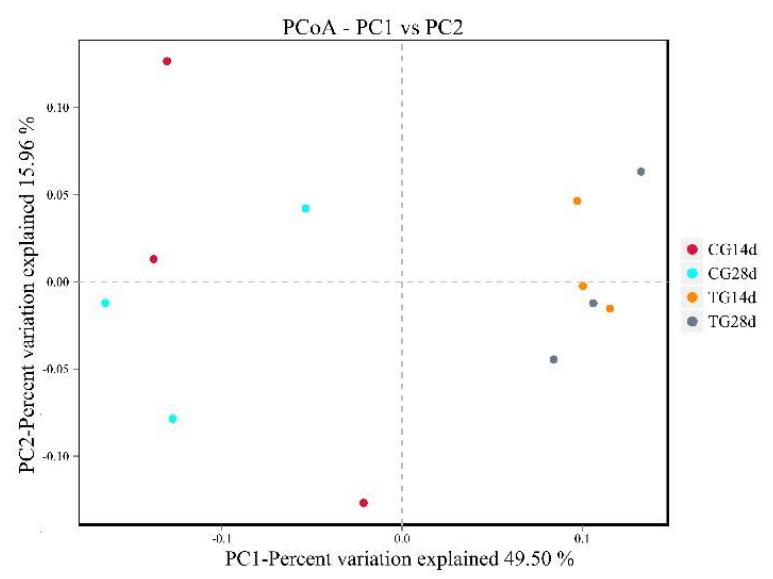
Figure 4. Principal coordinate analysis (PCoA) based on unweighted Unifrac distances. CG14d, control group after 14 days of feeding; CG28d, control group after 28 days of feeding; TG14d, treatment group ( S. cerevisiae at 10 7 CFU/g diet) after 14 days of feeding; TG28d, treatment group ( S. cerevisiae at 10 7 CFU/g diet) after 28 days of feeding.